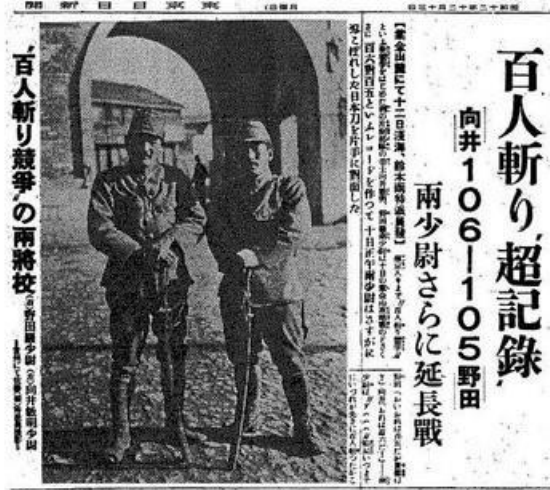
Figure 12. Japanese soldiers' killing contest. Source: The Japan Advertiser.